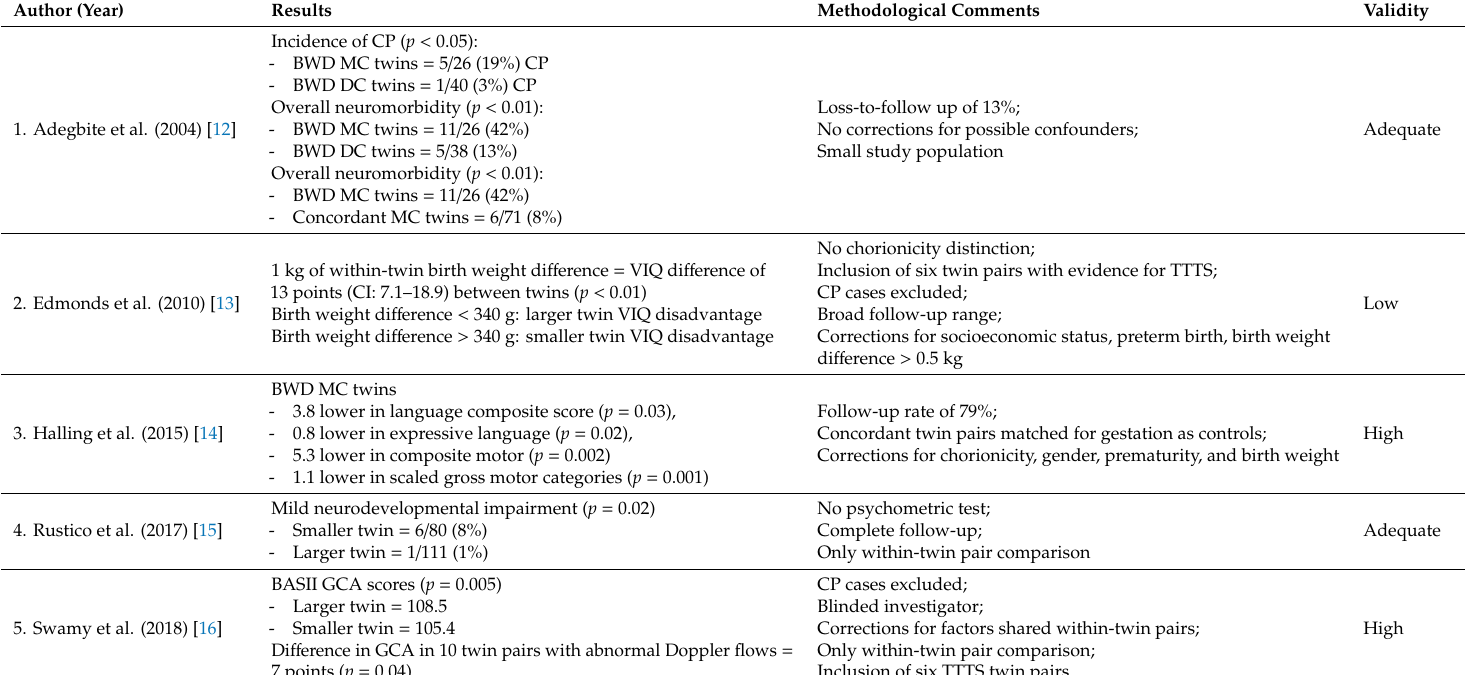
Table 2. Long-term neurodevelopmental outcomes in birth weight discordant monochorionic